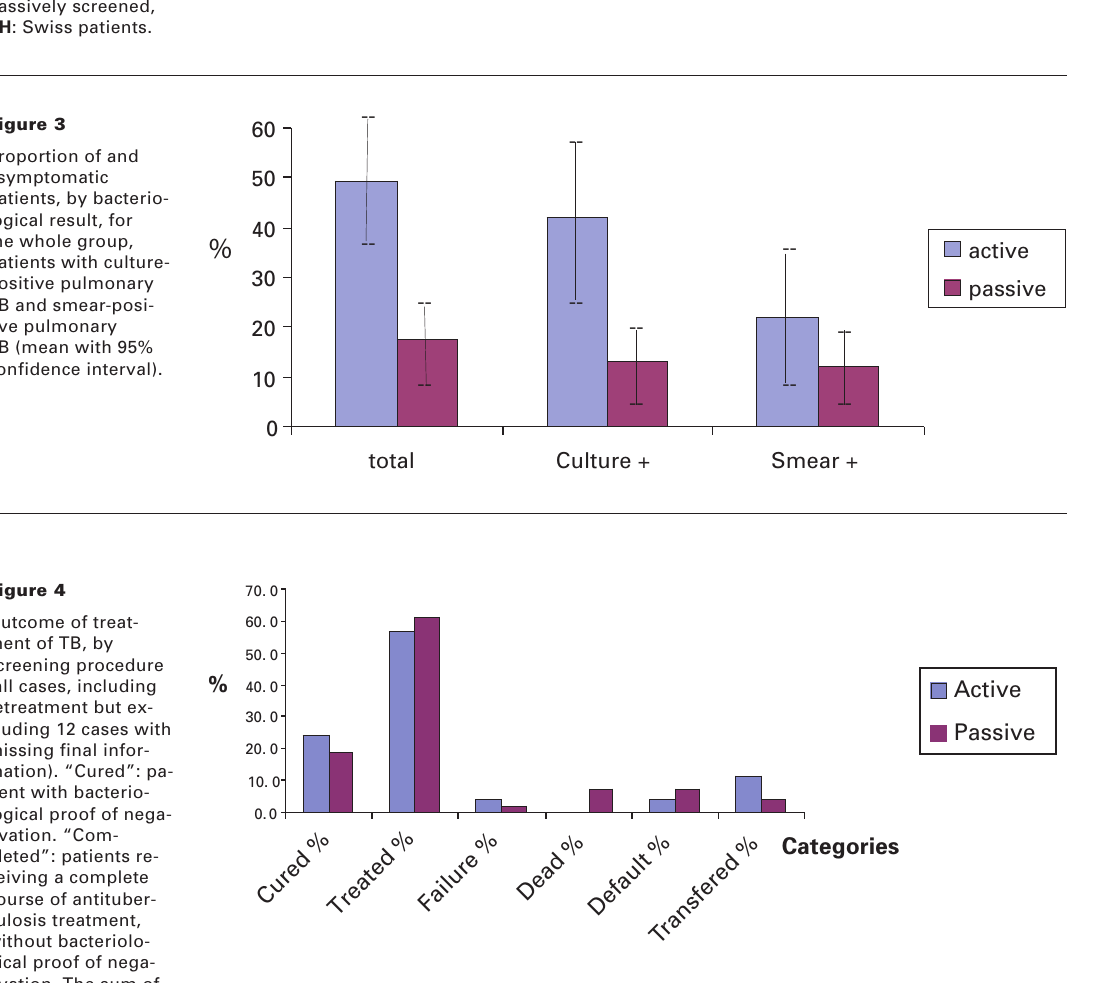
Demographic data of TB cases, by legal status and screening procedure. AS : asy- lum seekers actively screened, FW : for- eign workers, Other : illegal immigrants, students, tourists, asylum seekers passively screened, CH : Swiss patients.